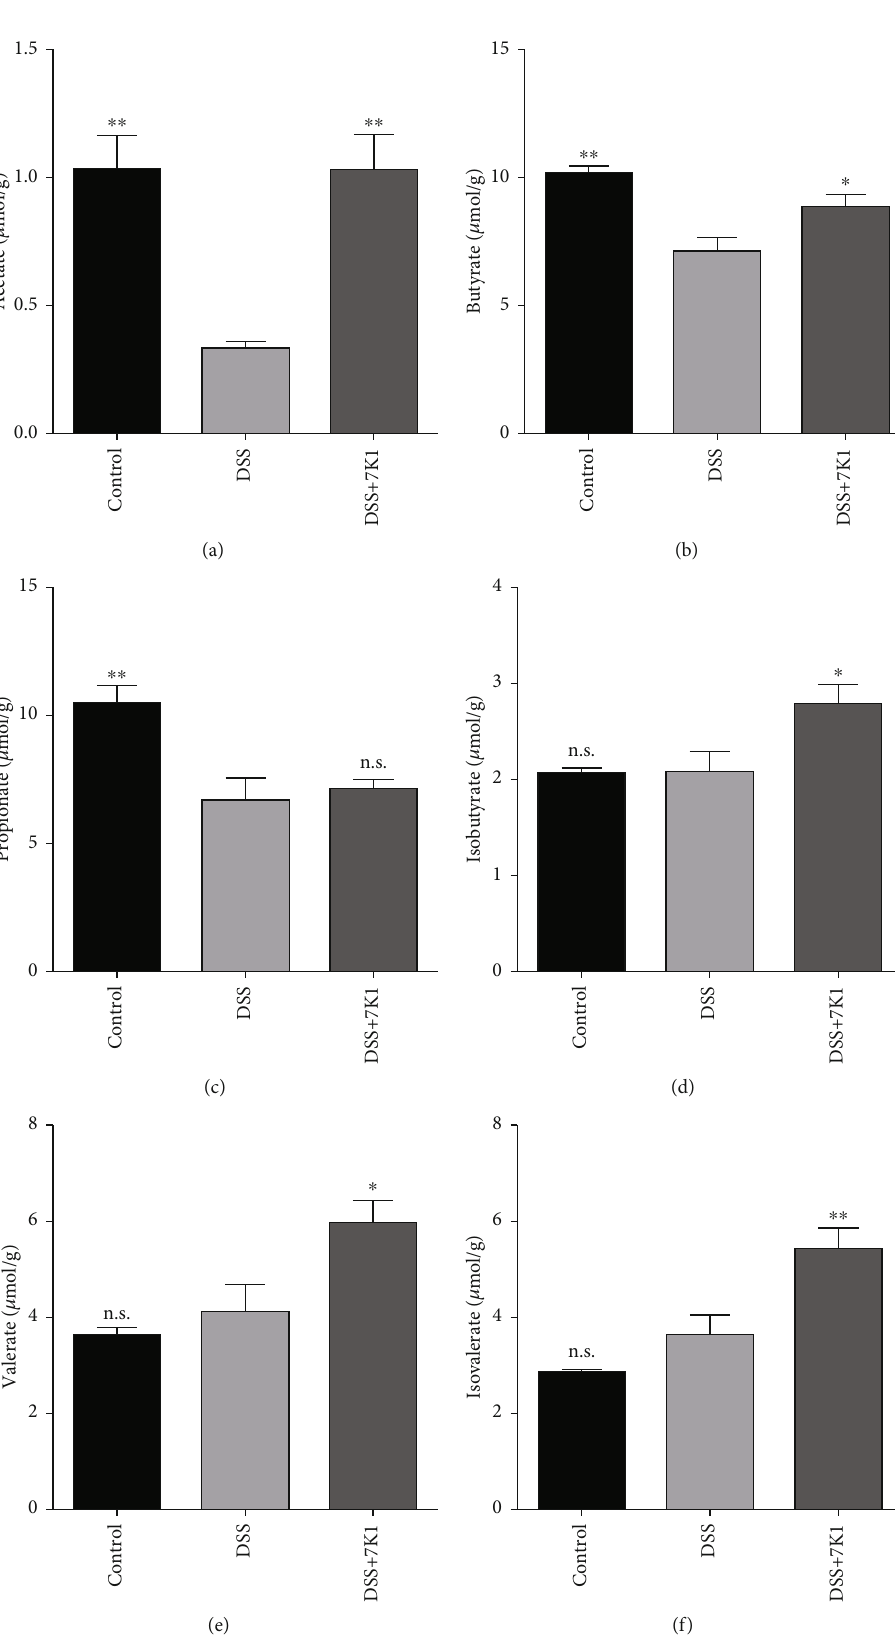
Figure 6: E ff ects of Bacteroides vulgatus on the concentrations of short-chain fatty acids in the fecal samples of mice. (a) Acetate. (b) Propionate. (c) Butyrate. (d) Isobutyrate. (e) Valerate. (f) Isovalerate. Five mice per